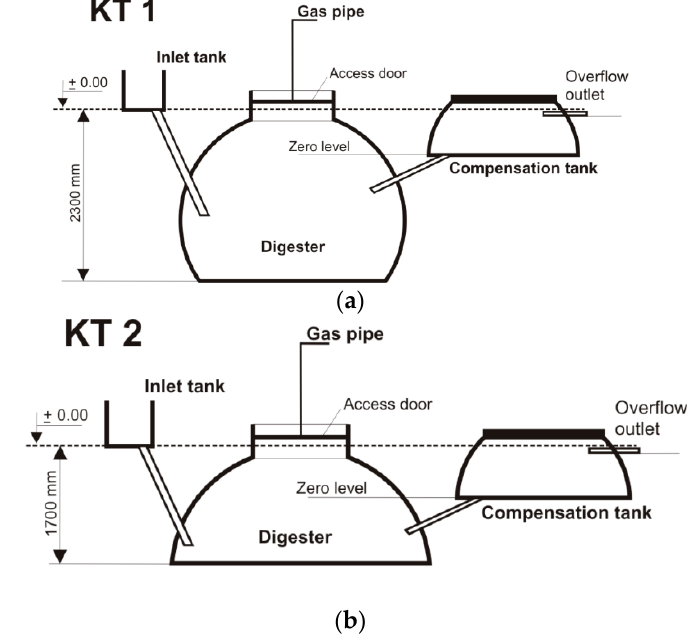
Figure 2. ( a ) Small-scale biogas plant—fixed dome model (KT1). Reprinted from [21]. ( b ) Small-scale biogas plant—fixed dome model (KT2). Reprinted from [21].